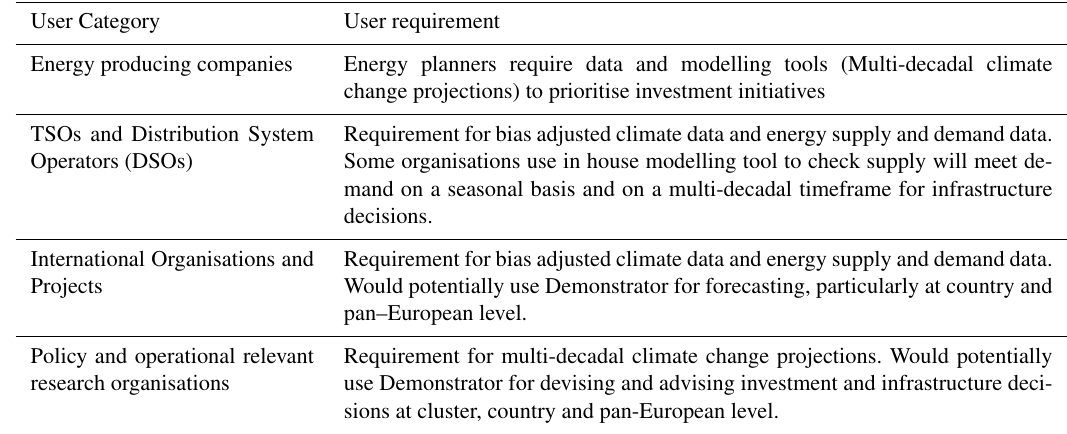
Table 1. Energy and climate sector requirements now and in the